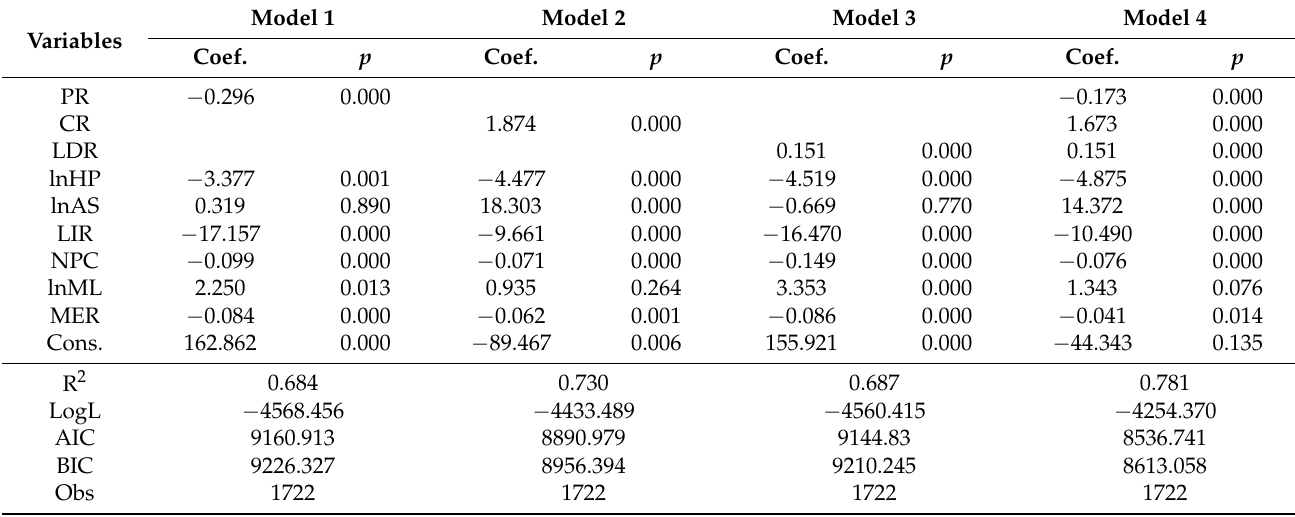
Table 5. Estimation results of the panel regression model.